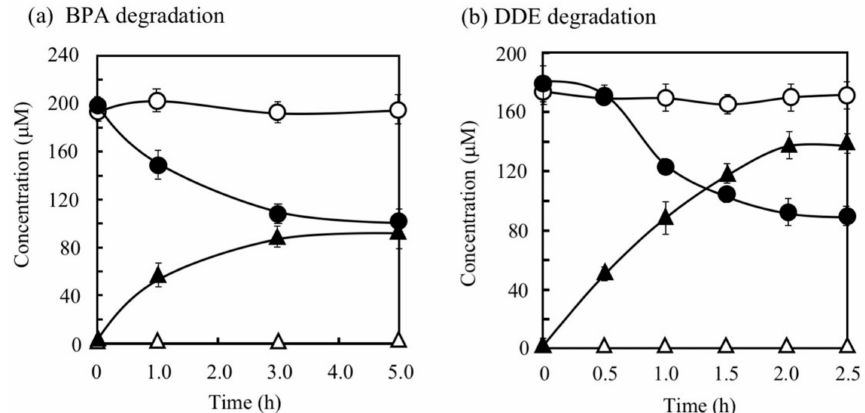
Figure 4. Degradation of bisphenol A (BPA) ( a ) and 4,4 (cid:48) -dihydroxydiphenylether (DDE) ( b ) by P. putida KT2440 cells with pBNMOA-F ( nmoA ) or pBBR1MCS-2 (vector) and the corresponding accumulation of HQ. Symbols: circles, BPA or DDE; triangles, HQ; open symbols, cells with vector; closed symbols, cells with nmoA . The average ± standard deviation from triplicate tests was shown.